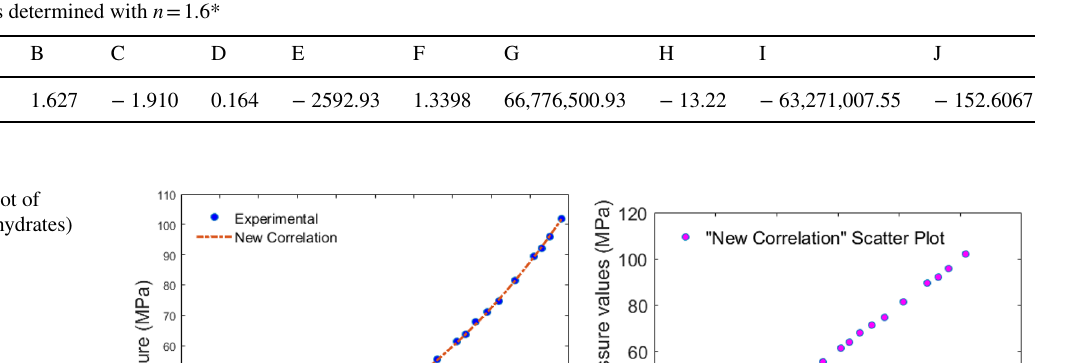
Temp (K) Experimental value Present (Sum et al. 1997)